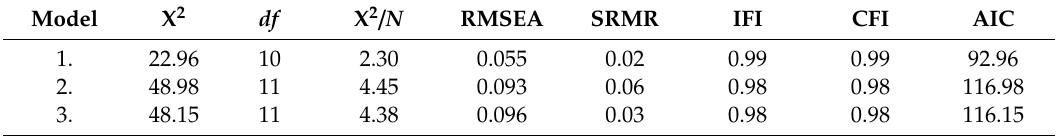
Table 4. Results of the SEM analyses for three causal